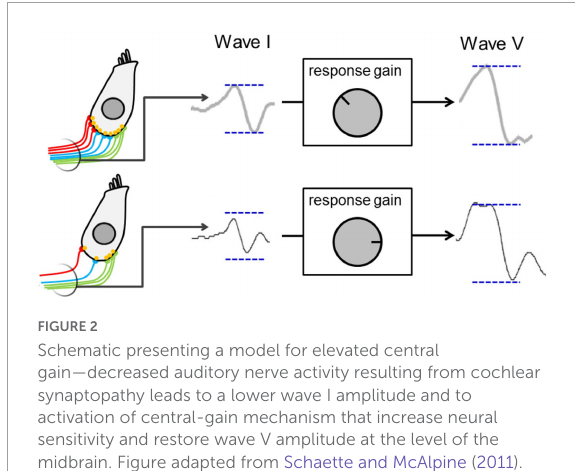
FIGURE2 Schematic presenting a model for elevated central gain—decreased auditory nerve activity resulting from cochlear synaptopathy leads to a lower wave I amplitude and to activation of central-gain mechanism that increase neural sensitivity and restore wave V amplitude at the level of the midbrain. Figure adapted from Schaette and McAlpine